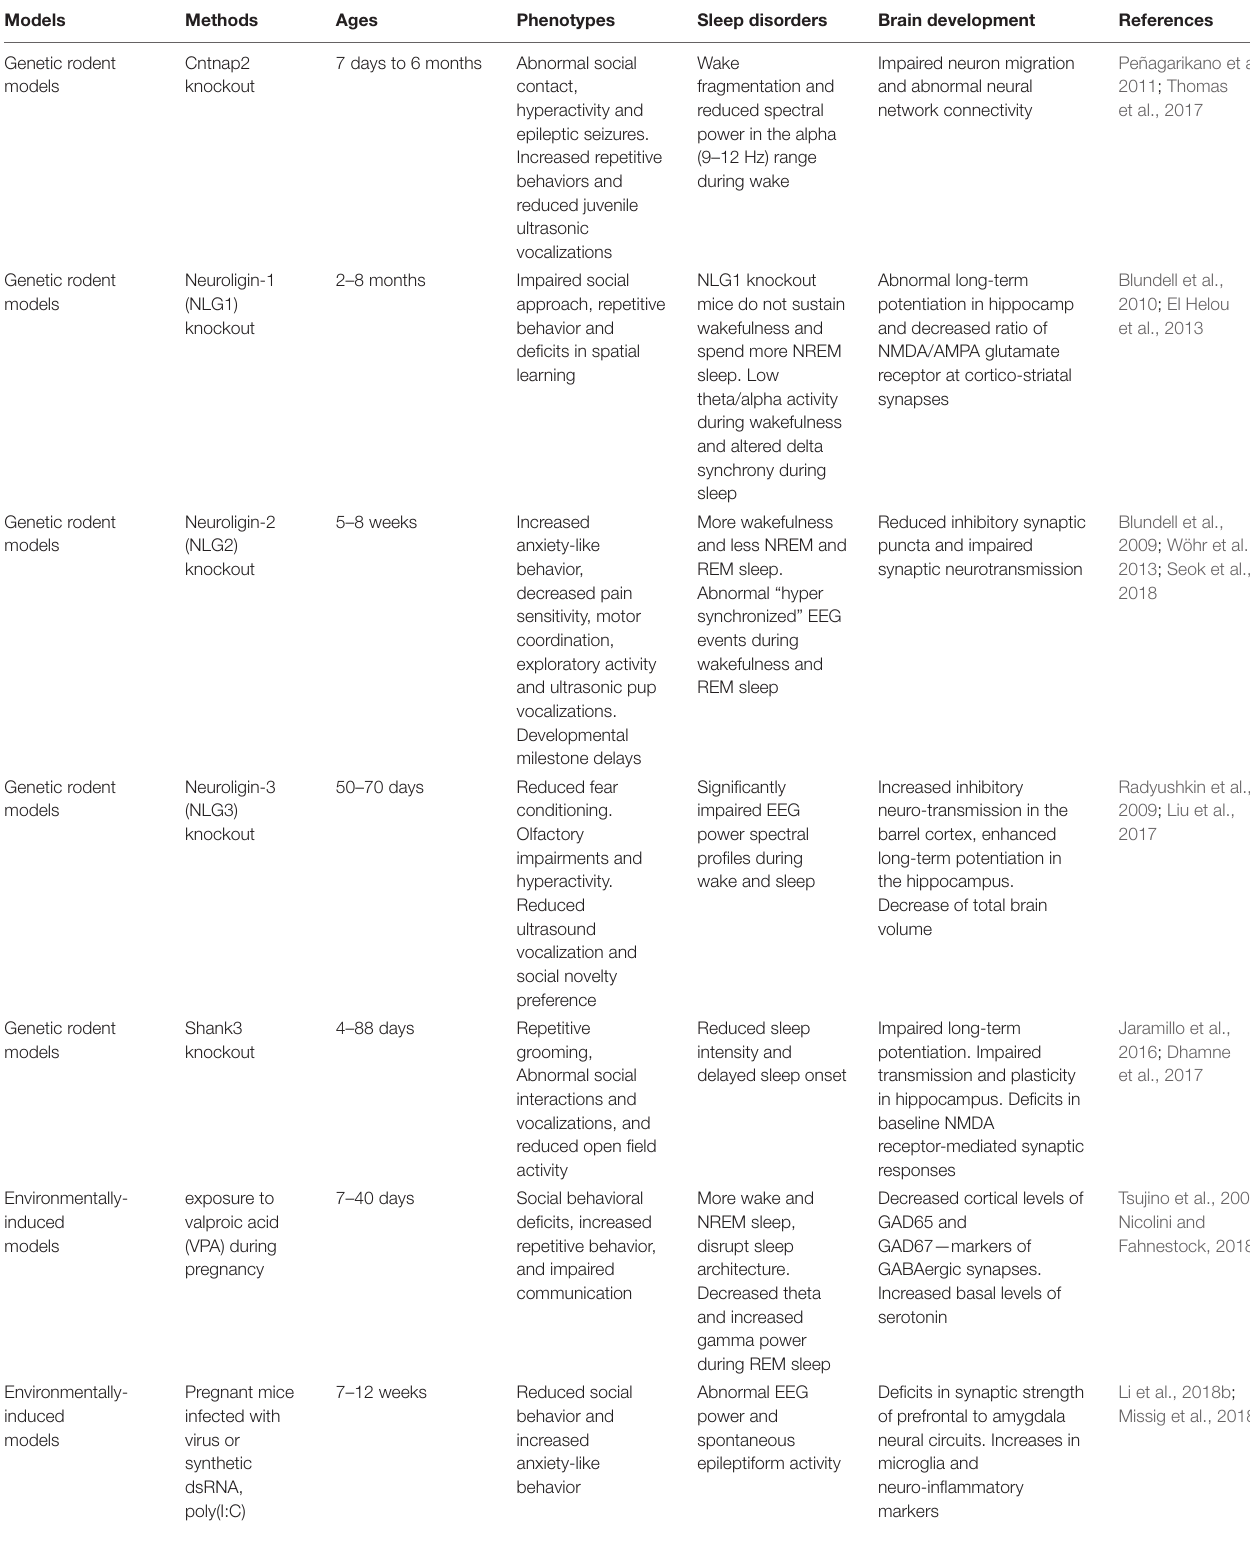
TABLE 1 | Autism-relevant phenotypes in selected rodent